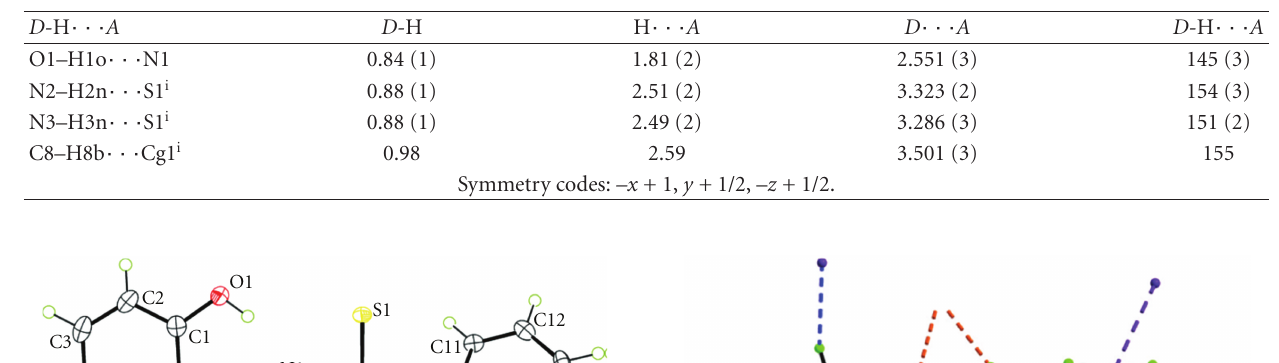
Table 3: Hydrogen-bond geometry ( ˚A, ◦ )